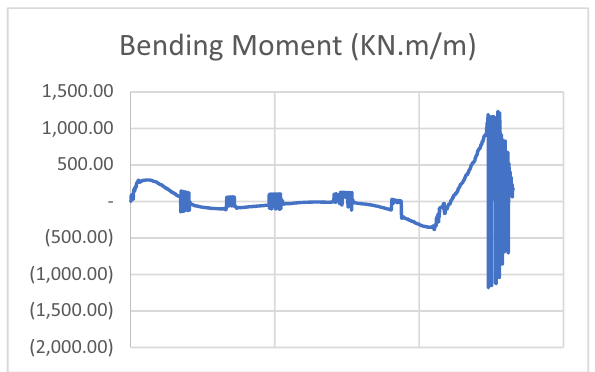
Figure 5: Bending moment distribution under the footing of the northern wall.